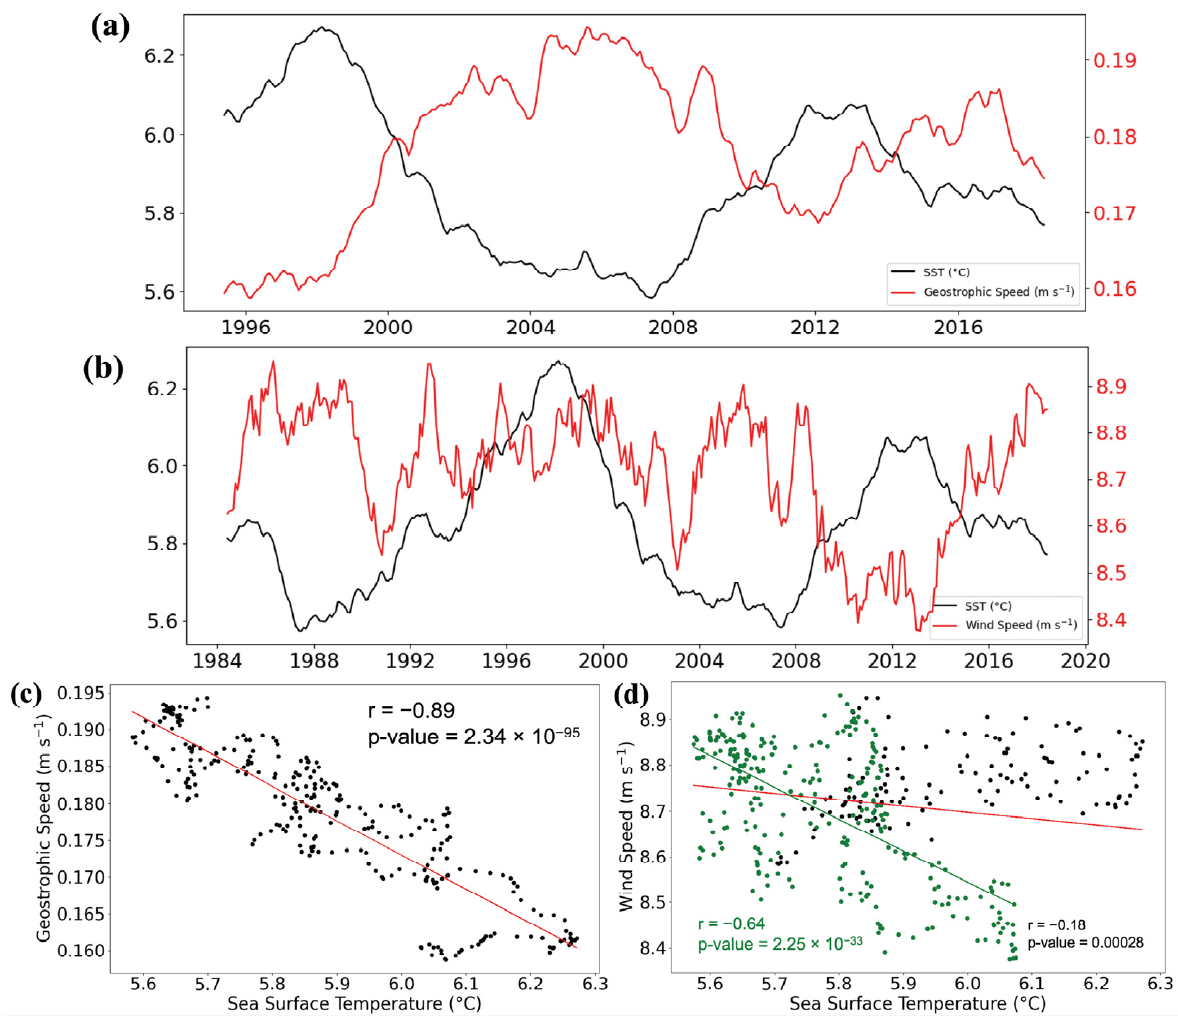
Figure 10. Time series of the 5-year running means of Sea Surface Temperature (SST) (in black) and ( a ) geostrophic speed (in red), and ( b ) wind speed (in red). The Pearson Correlation between the 5-year running means of ( c ) SST and geostrophic current, and ( d ) SST and wind speed (in black), excluding the years 1991 to 2001 (in green). Note the different x-axes for panels ( a ) and ( b